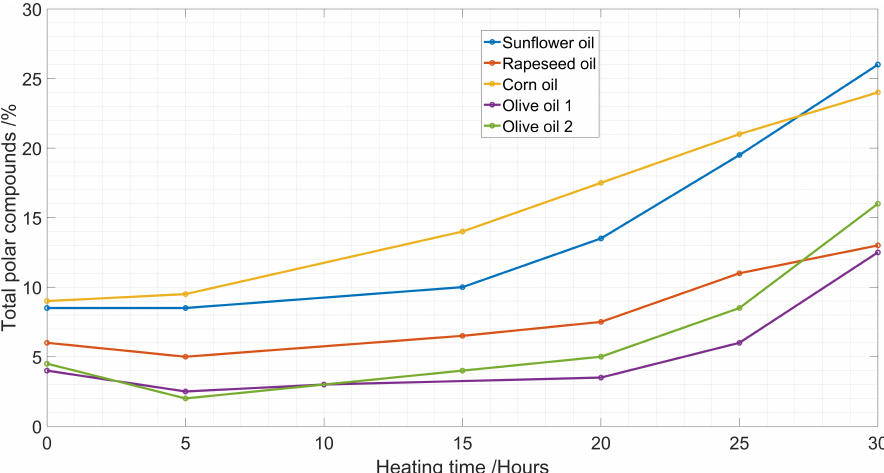
Figure 2. Increase of total polar compounds with heating hours.